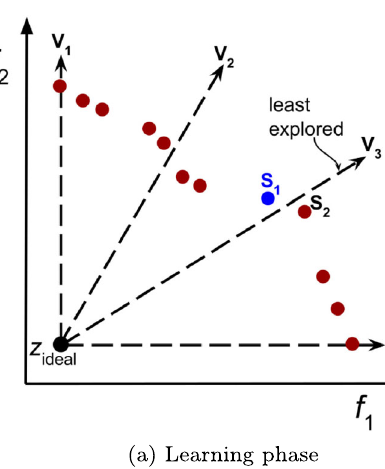
Fig. 6 Performing pairwise comparisons as preference information in